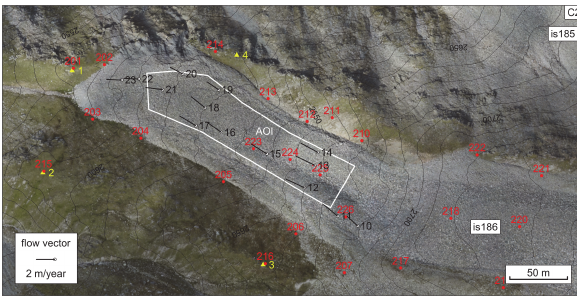
Geodetic network comprising stable points (yellow) and observation points (white). Points in red are temporarily marked GCPs/CPs of the UAV campaign of 22.8.2017. The orthophoto shown dates from this campaign. The white polygon delineates the area of interest (AOI) considered for computing the mean annual flow velocity as needed in the velocity graph (see Section 6) Figure 5. Mean annual horizontal flow vectors for 2016-2017